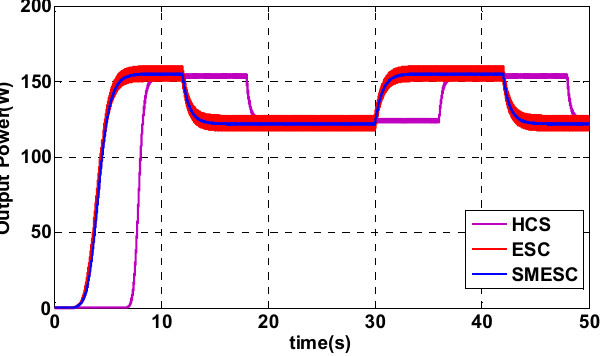
Figure 11. Three algorithm system dynamic responses: High wind speed dropped and raised again.